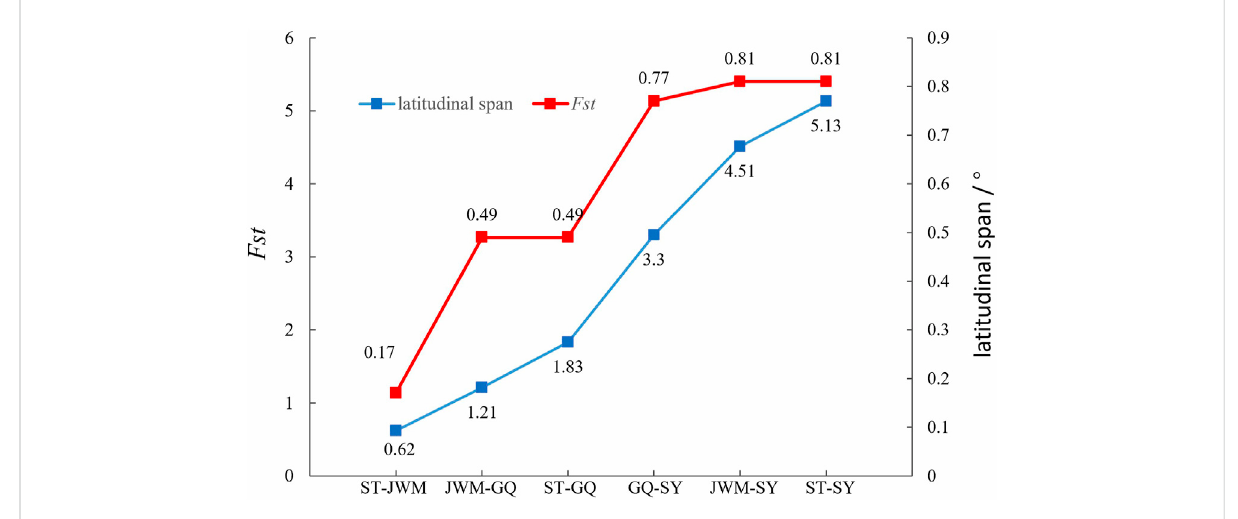
FIGURE 9 The relation between F ST between geographic groups and their latitudinal